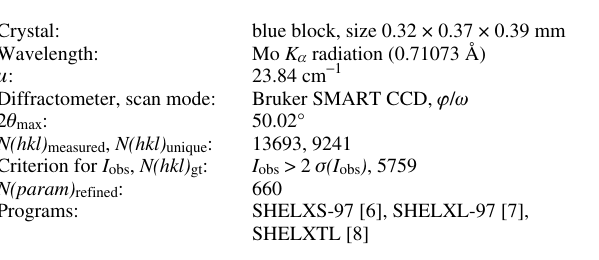
Table 1. Data collection and